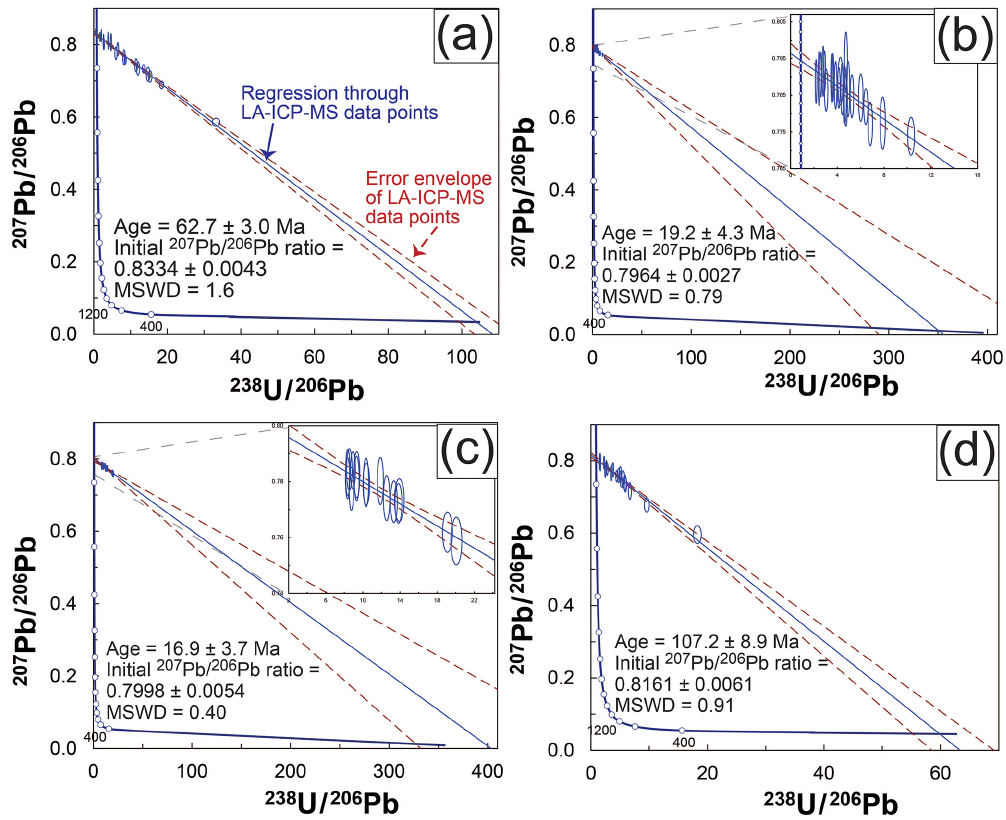
Figure 6. Tera–Wasserburg diagrams of (a) Albula-1, (b) Grimsel-1, (c) Grimsel-2, and (d) Heyuan-1 epidote samples with 50µm measure- ments. All ratios are uncorrected for initial Pb. Ages are calculated from the lower intercept of the regressions through the analyses with the concordia, whereas initial 207 Pb / 206 Pb ratios are calculated from the upper intercept of the regressions with the y axis. Data-point error ellipses are 2 σ , and age uncertainties are 95% confidence. Error envelopes are plotted with Isoplot 3.7.5 (Ludwig,